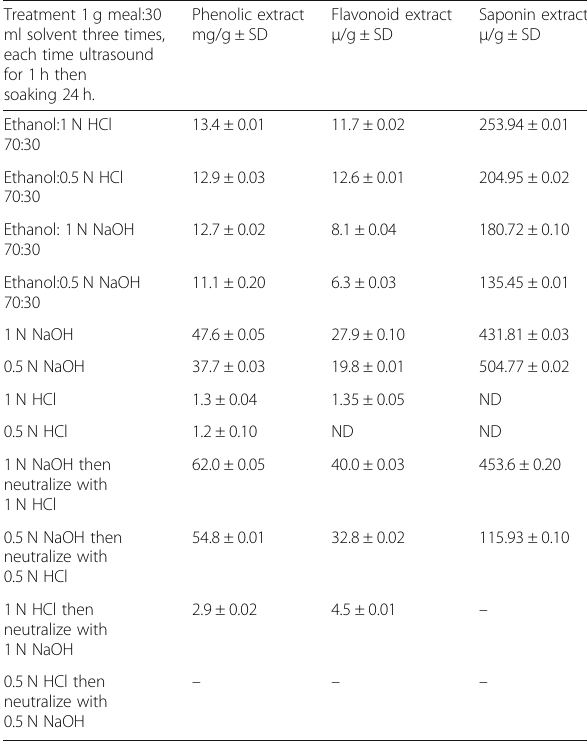
Table 1 Effect of different treatments on the yield of phenolic, flavonoid, and saponin compounds extracted from jojoba hull at room temperature Treatment 1g meal:30 ml solvent three